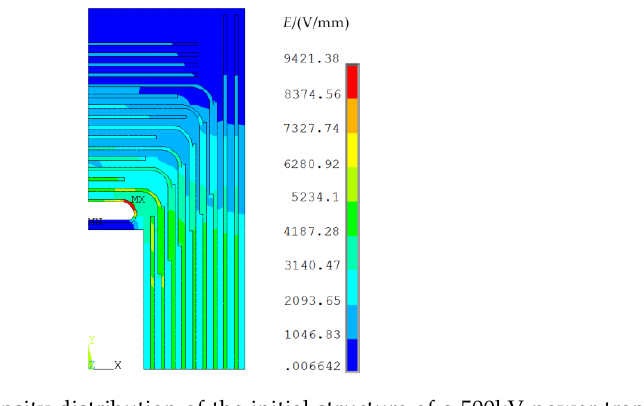
Figure 2. Electric field intensity distribution of the initial structure of a 500kV power transformer main insulation.